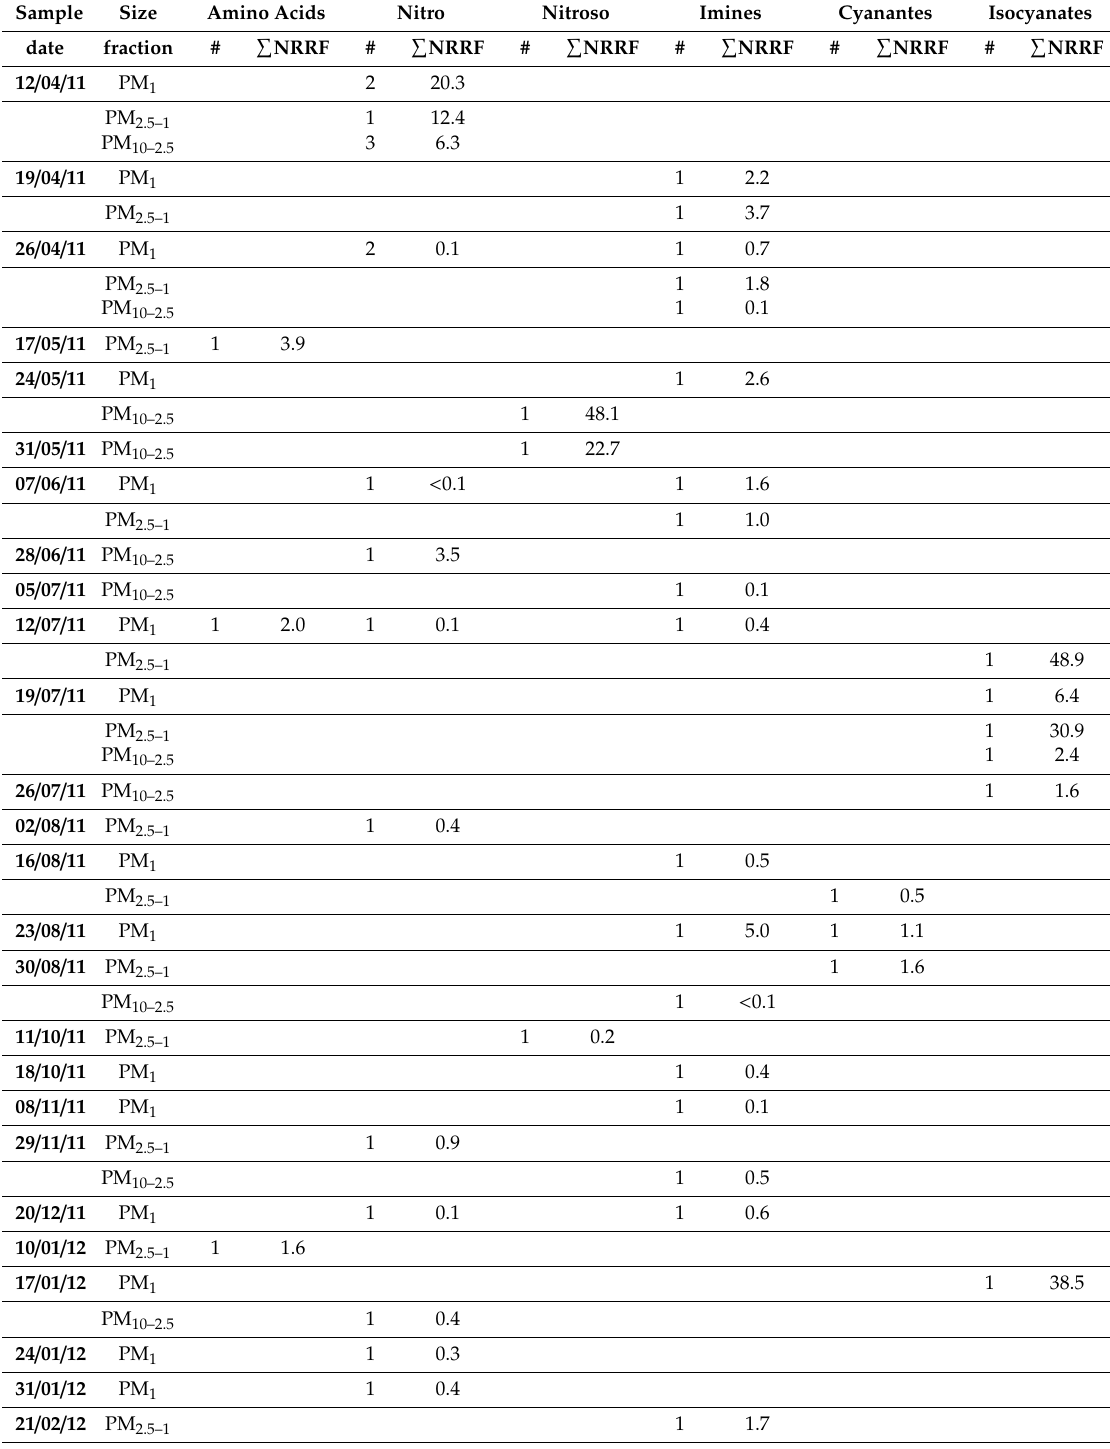
Table 1. Summary of organic N functional groups tentatively identified with very low